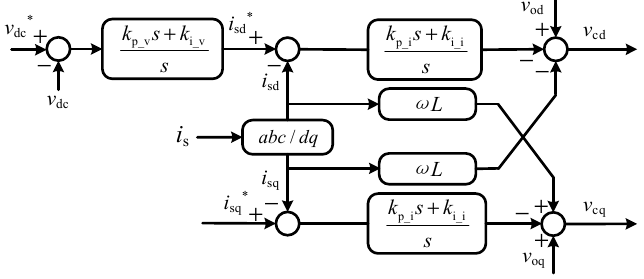
Figure 3. The diagram of the d-q axis decoupling double closed-loop control strategy.